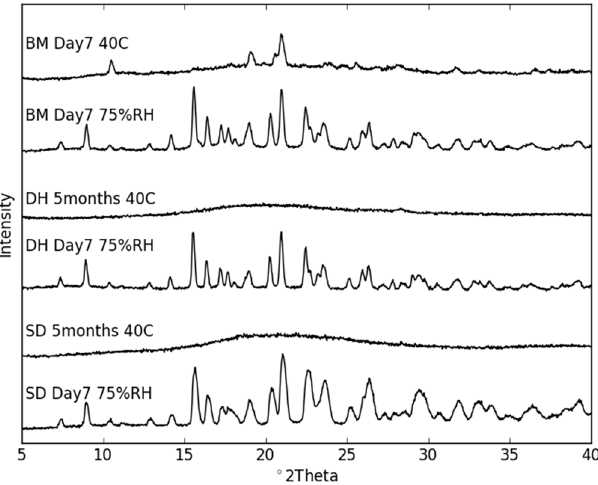
Figure 7. XRPD diffractograms of co-amorphous BM, DH and SD samples stored for seven days (BM) and five months (DH and SD) at 40 °C under dry conditions, as well as for seven days at 25 °C/75% RH.